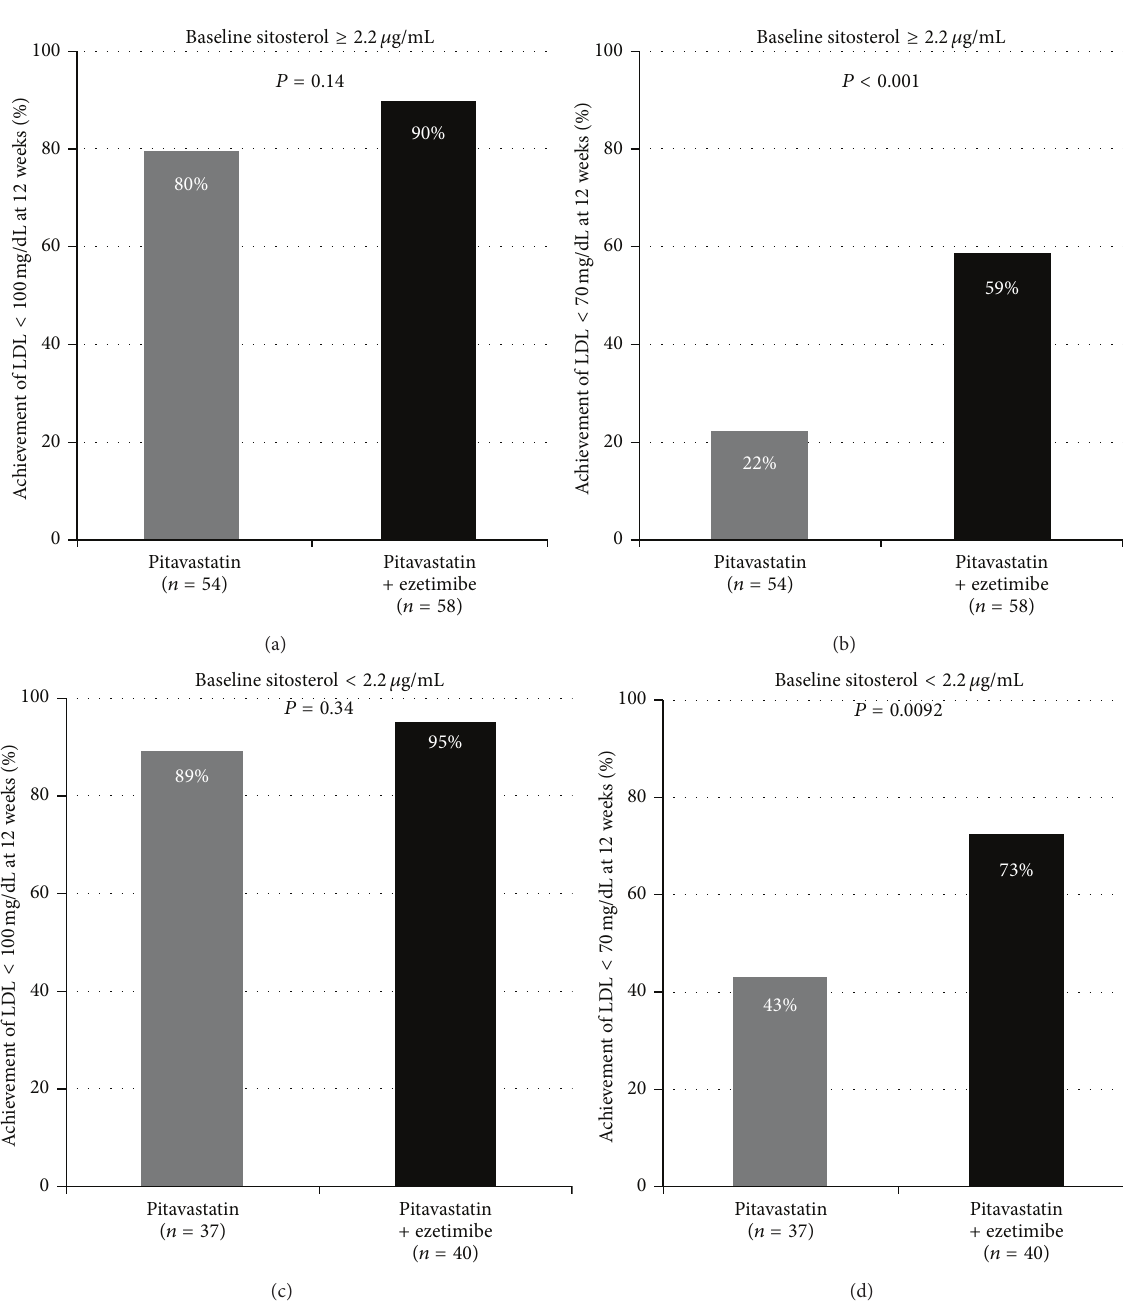
Figure 5: The impacts of baseline levels of sitosterol and lipid-lowering treatment strategy. (a) The achievement rate of LDL-C less than 100mg/dL and (b) less than 70 mg/dL (b) in each treatment group whose baseline sitosterol is equal to or more than 2.2 𝜇 g/mL. (c) The achievement rate of LDL-C less than 100 mg/dL and (d) less than 70 mg/dL in each treatment group whose baseline sitosterol is less than 2.2 𝜇